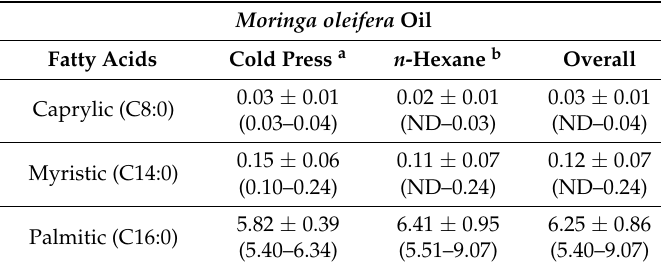
Table 3. Fatty acid composition (g/100 g) of